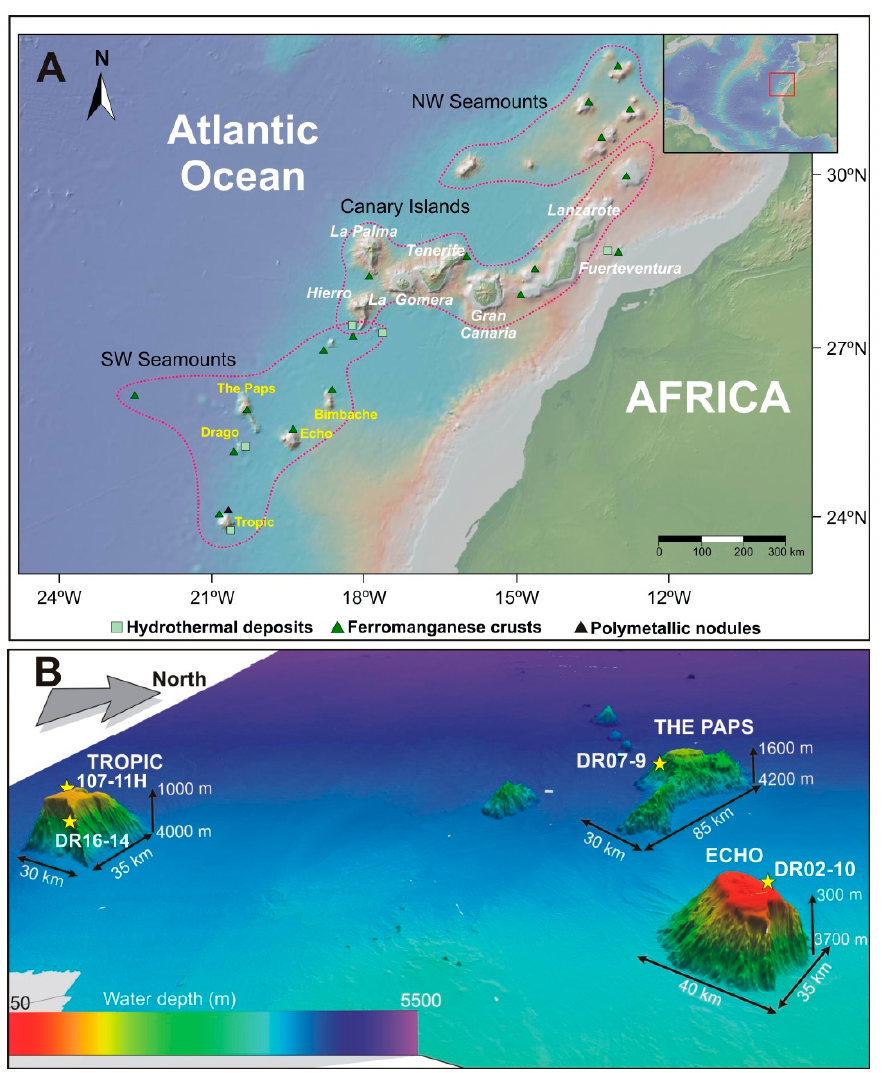
Figure 1. ( A ) regional setting of the Canary Islands Seamounts Province (CISP). General view of the study area where the Canary archipelago and the most important seamounts of the southwest area of CISP with their associated mineral deposits are displayed (Map from GeoERA-MINDeSEA project [50]); ( B ) 3D view of the studied seamounts and location of the sampling site.